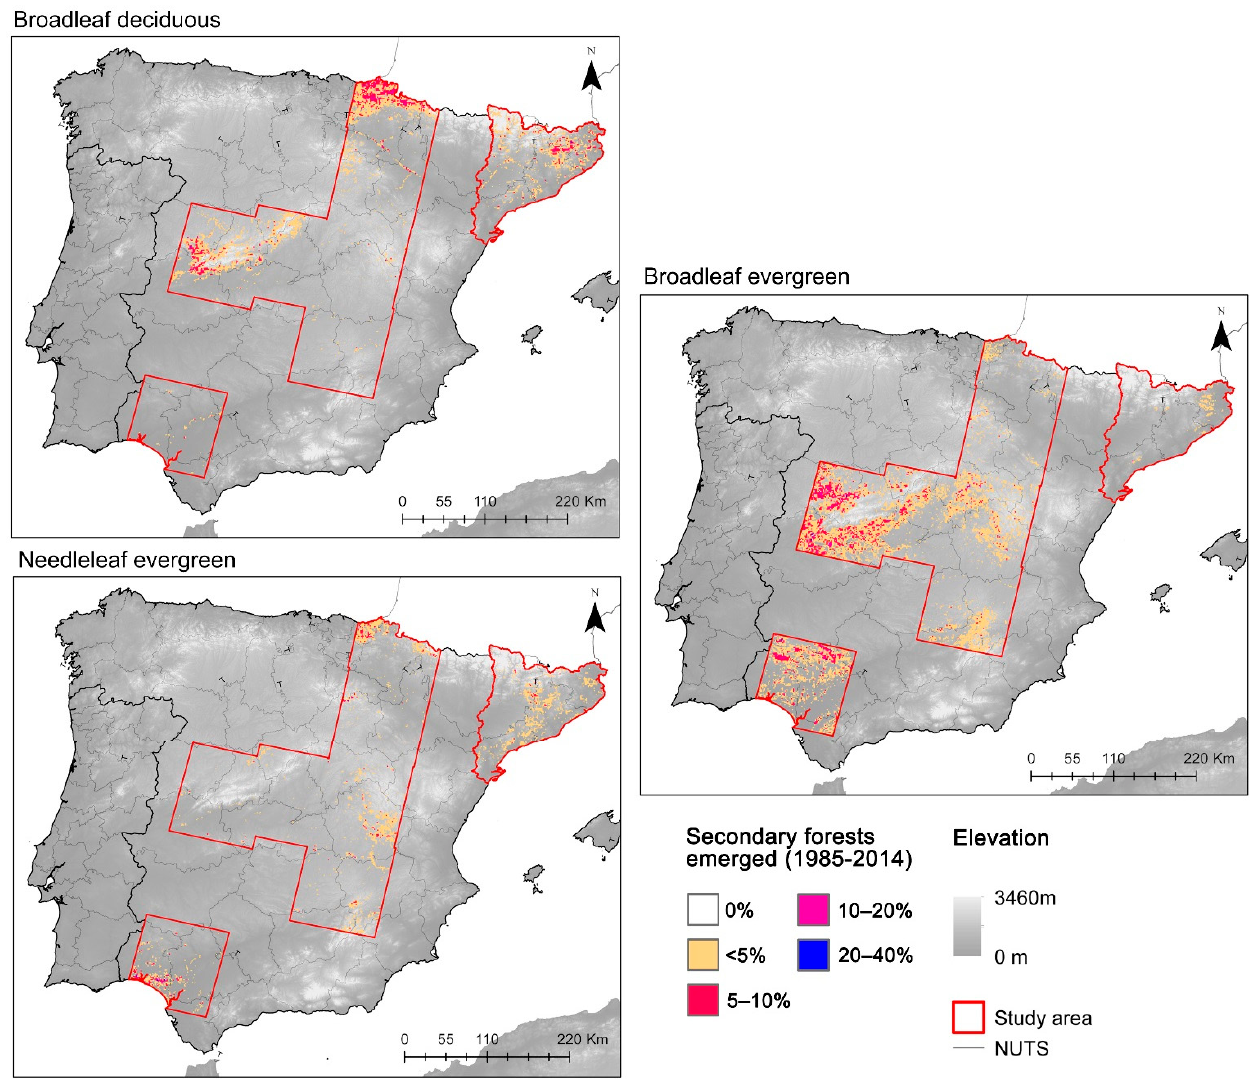
Figure 2. Secondary forest distribution and area (percentage of 10 km pixels) during 1985–2014 for the main forest leaf-habit types in the Iberian Peninsula: broadleaf deciduous, broadleaf evergreen and needleleaf evergreen.